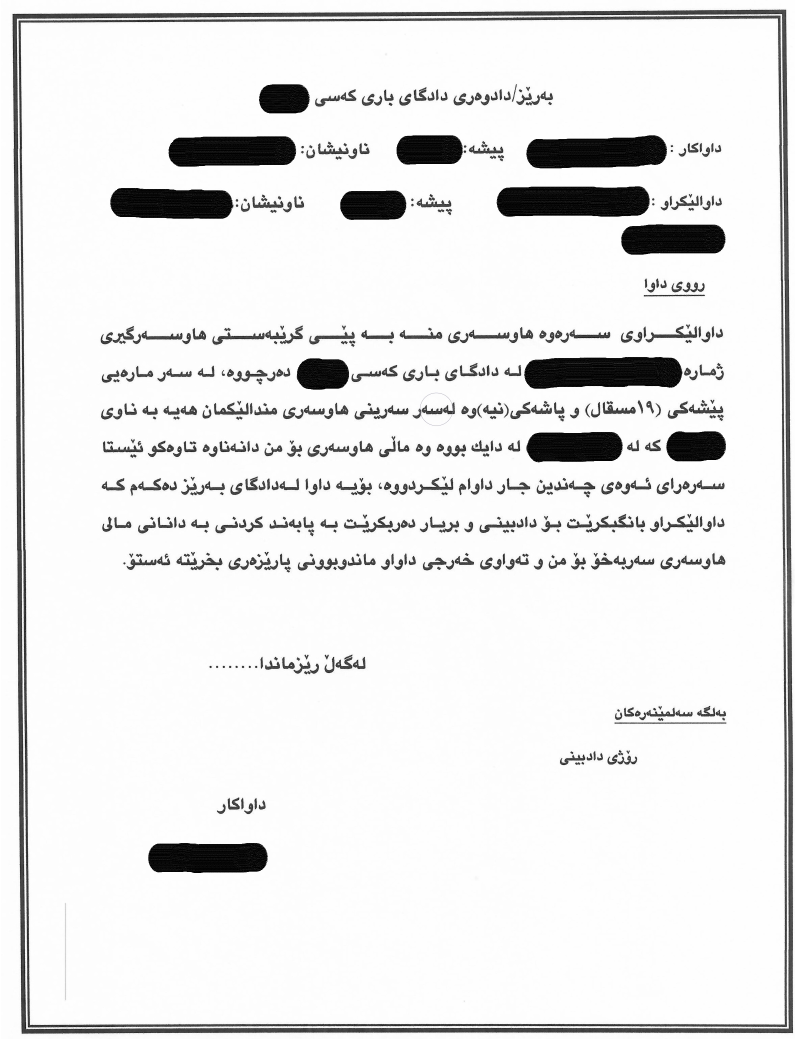
Figure 2. Scanned court document image sample for data set preparation.